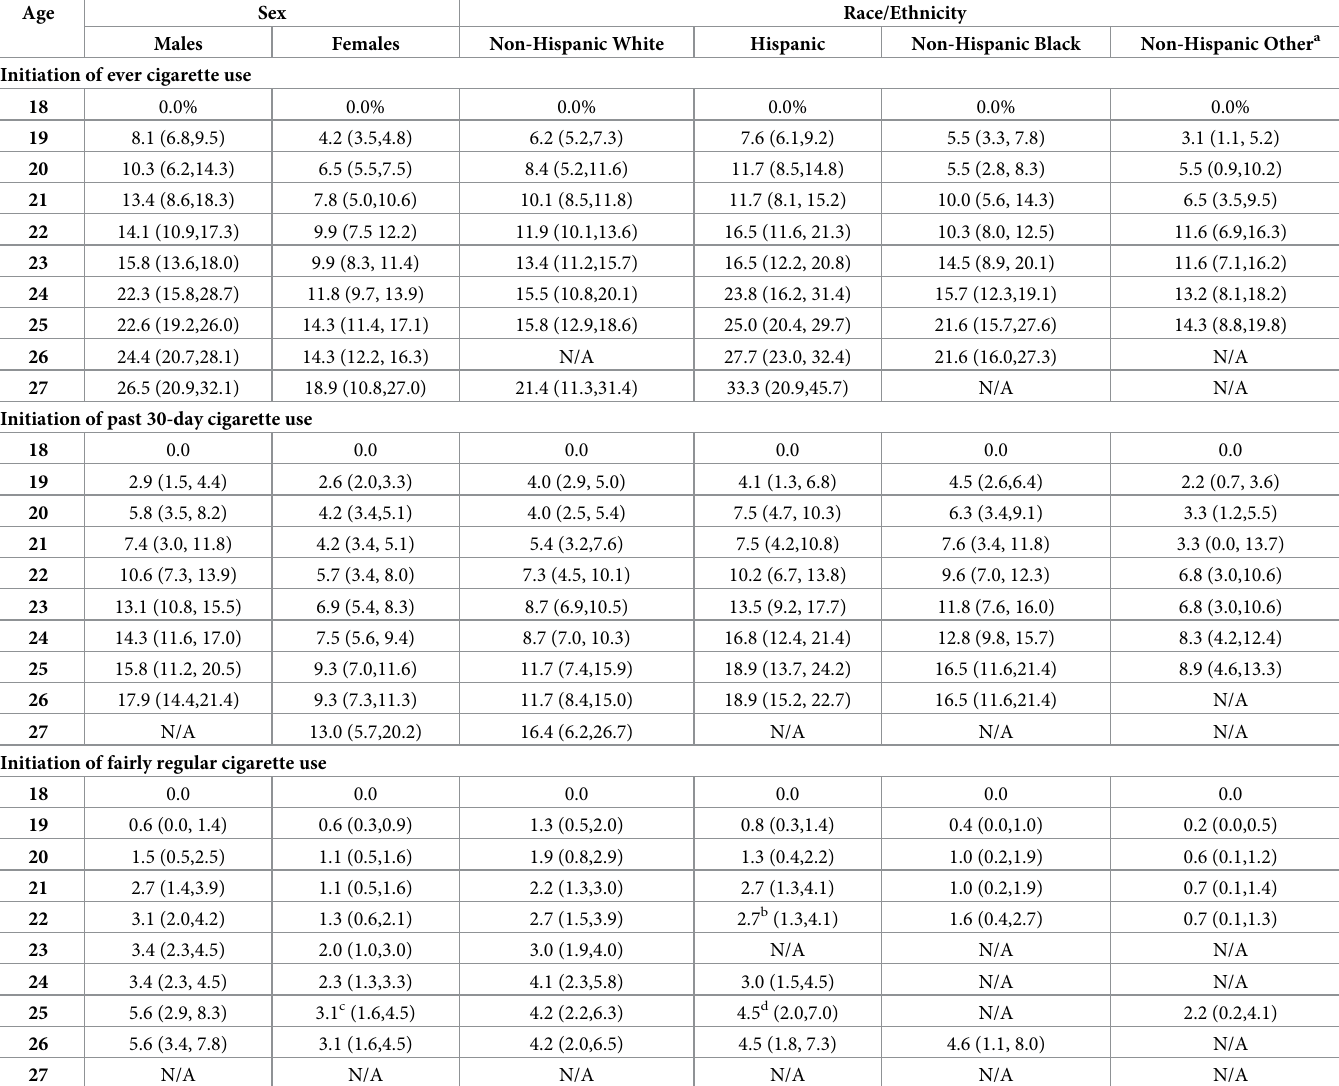
Table 4. Estimated cumulative incidence (and 95% CIs) of the age of initiation of different cigarette outcomes by sex and by race/ethnicity �